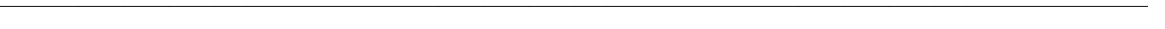
Fig. 5. Chondrichthyan scales from the Devonian and Carboniferous of Belarus. A, B, D – G, K – P, R, U, W , crown views; C , oblique lateral, H – J, S, T, anterior, Q , posterior and V , oblique posterior views. A , B , Karksilepis cf. parva Märss, 2008. A, SPCG 47/19-50t, Lepel-1 core, depth 194 m, sample 19, Eifelian, Kostyukovichi Regional Stage; B, PM SPU 82-14, Buda Dalnyaya-35 core, depth 231.7 m, sample 6, Upper Emsian, Vitebsk Regional Stage. C – E , Lugalepis sp. C, SPCG 47/3-3, Lepel-1 core, depth 175.4 m, sample 3; Givetian, Polotsk Regional Stage; D, E, SPCG 9/3a-1, Bykhov-151 core, depth 141.3 m, sample 3a, Eifelian, Gorodok Regional Stage. F , G , Ohiolepis type. F, PM SPU 82-15, Berzhetsy-475 core, depth 166 m, sample 8, Lower Tournaisian, Upa Regional Stage; G, PM SPU 82-16, 441 core, depth 280 m, sample 25v, Lower Tournaisian, Malevka Regional Stage. H , type A, SPCG 41/6b-1, Pinsk-26 core, depth 415.7 m, sample 6b, Eifelian, Kostyukovichi Regional Stage. I , J , type B. I, PM SPU 82-17, 331 core, depth 292.2 m, sample 16a, Lower Tournaisian, Malevka Regional Stage; J, PM SPU 82-18, 331 core, depth 278–282 m, sample 13d, Lower Tournaisian, Upa Regional Stage. K , L , protacrodontid type. K, SPCG 70/10-1, Knyshevichi-7 core, depth 2060.3 m, sample 10, Lower Famennian, Drozdy Regional Stage; L, SPCG 96/37a-2, Starobin-239 core, depth 1043.8–1047.6 m, sample 37a, Lower Famennian, Petrikov Regional Stage. M , N , Type C. M, PM SPU 82-19, 331 core, depth 292.2 m, sample 16a, Lower Tournaisian, Malevka Regional Stage; N, PM SPU 82-20, Berzhetsy-475 core, depth 166 m, sample 8, Lower Tournaisian, Upa Regional Stage. O – R , ctenacanthid type. O, SPCG 97/1a-4, Brinev-6 core, depth 446.7 m, sample 1a, Lower Famennian, Petrikov Regional Stage; P, PM SPU 82-21, 506 core, depth 241.6 m, sample 56b, Upper Famennian, Borovoe Regional Stage; Q, PM SPU 82-22, 441 core, depth 304–307 m, sample 30v, Lower Tournaisian, Malevka Regional Stage; R, PM SPU 82-23, same core and age. S , hybodontid type, PM SPU 82-24, Berzhetsy-475 core, depth 166 m, sample 8, Lower Tournaisian, Upa Regional Stage. T – W , euselachian type. T, PM SPU 82-25, 482 core, depth 423 m, Upper Famennian, possibly Starobin Regional Stage; U, PM SPU 82-26, same core and age; V, PM SPU 82-27, same core and age; W, PM SPU 82-28, 506 core, depth 241.6 m, sample 56b, Upper Famennian, Borovoe Regional Stage. Scale bars A, C–M, O–T, V, W – 200 µm; B, N, U – 500